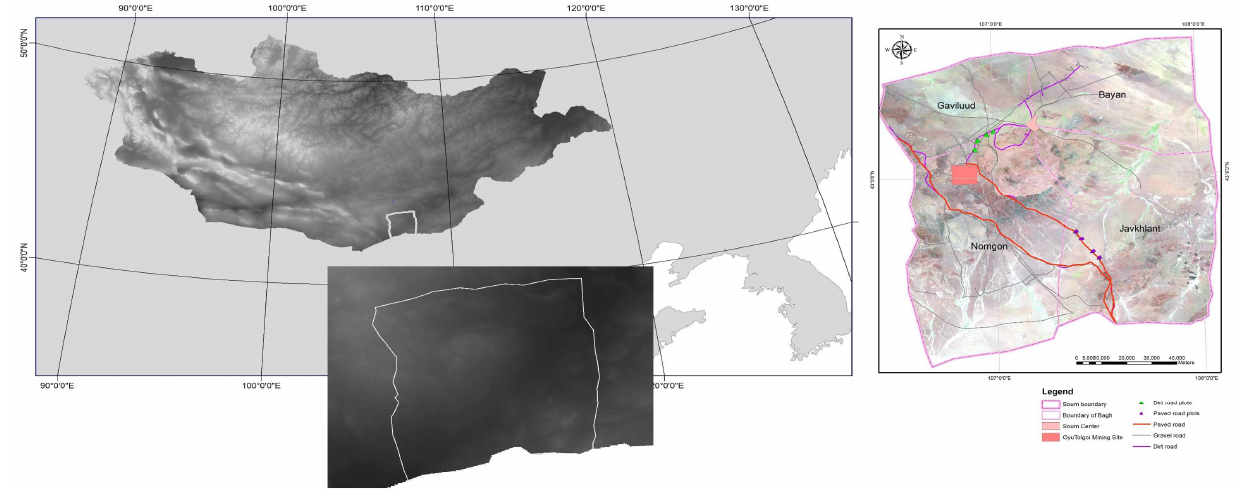
Figure 2. The study area and plots along the dirt and paved roads, with three different distances from the